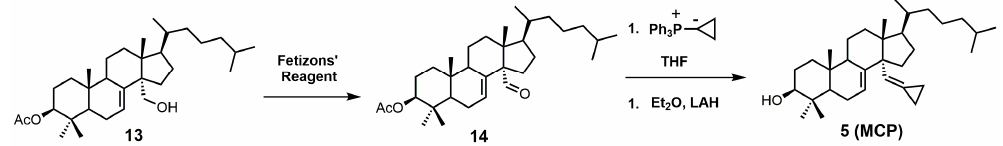
Figure 4. The synthesis of 14 α -methylenecyclopropyl- Δ 7-24,25-dihydrolanosterol (MCP) ( 5 ).